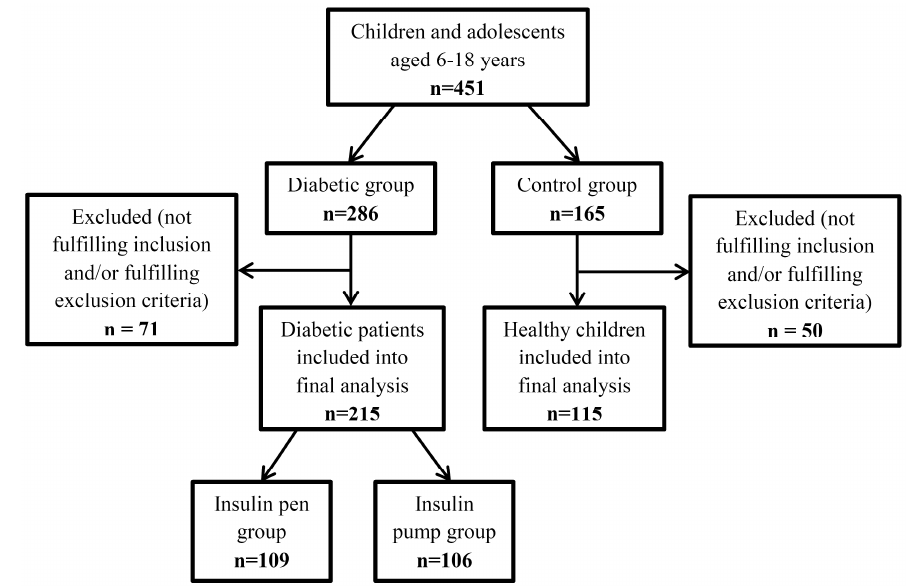
Figure 1. Flow chart of study participant selection.